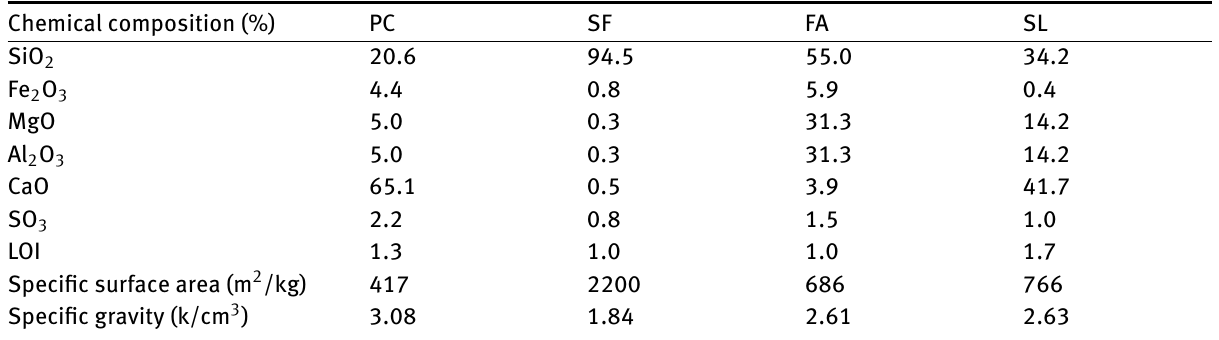
Table 1: Chemical composition and physical properties of cementitious materials Chemical composition (%) PC